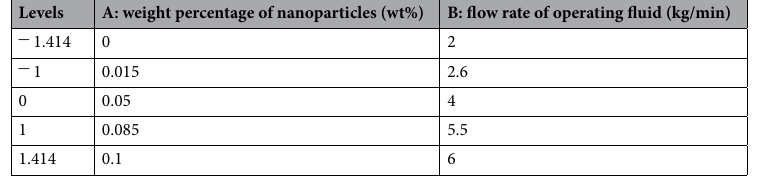
Table 5. The levels of factors.